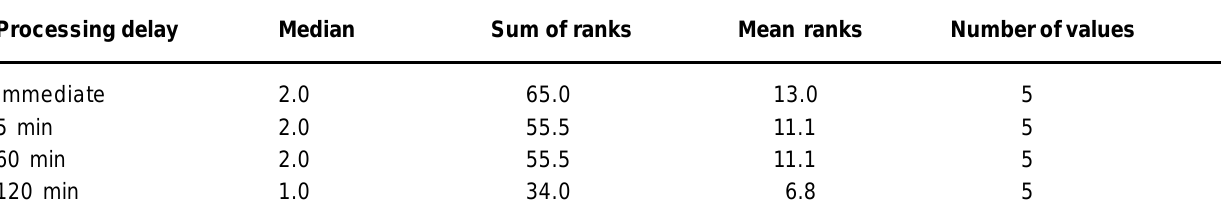
Hc= 5.164999; Chi-square with 3 degrees of freedom; Probability = 0. 160106 (non significant)